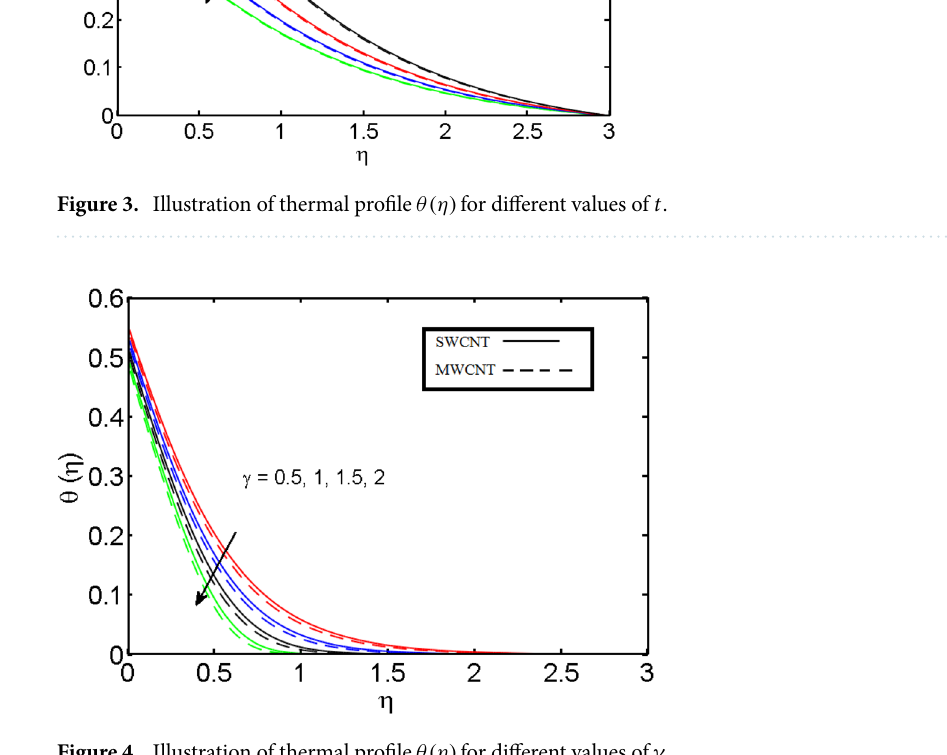
Figure 4. Illustration of thermal profile θ(η) for different values of γ